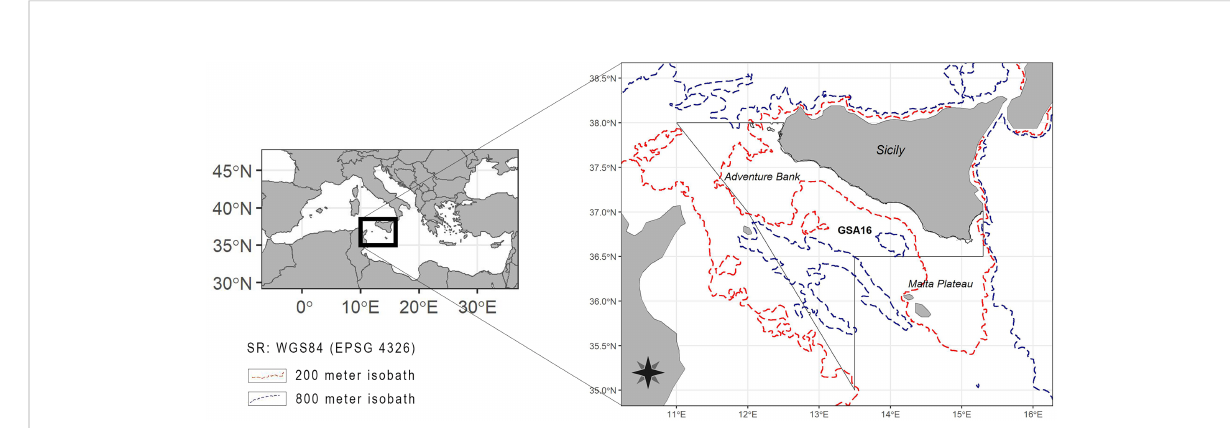
FIGURE 1 Map of the Strait of Sicily showing the location of the study area where the data of the P. regalis were collected: Geographical Sub-Area 16, south of Sicily. Red and blue dashed lines indicate the 200- and 800-m isobaths